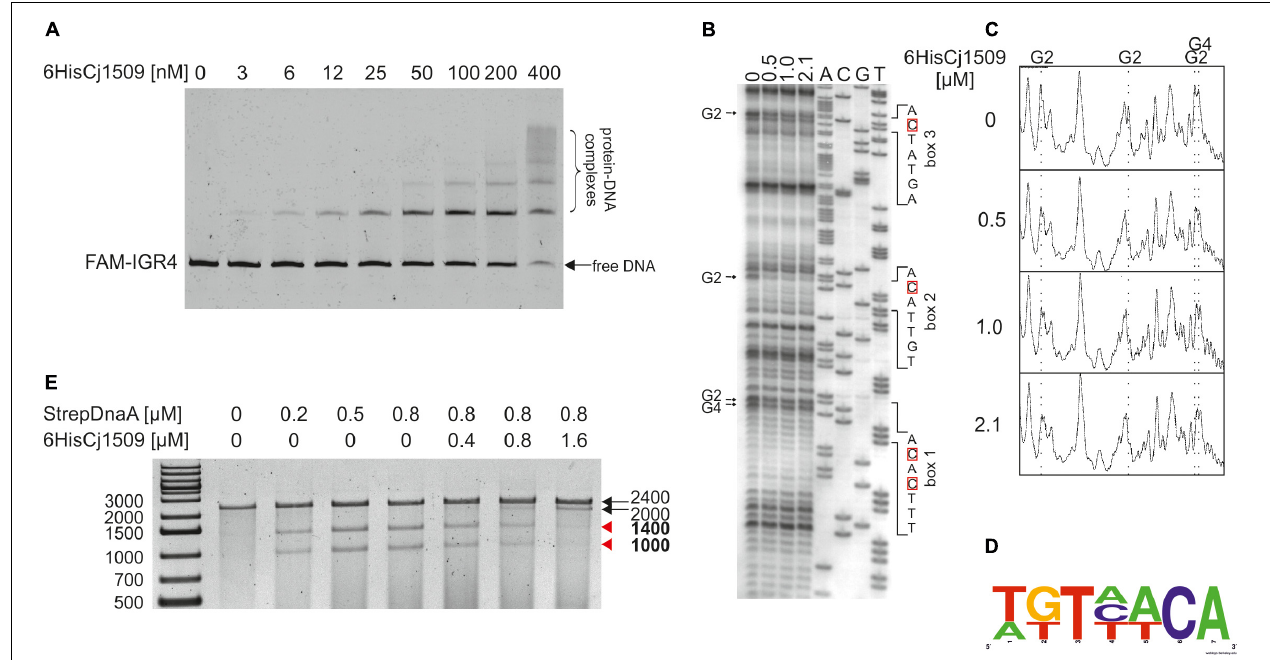
FIGURE 6 | Analysis of 6HisCj1509 protein binding to the IGR4 region and influence of 6His1509 on DUE unwinding. (A) EMSA analysis of nucleoprotein complex formation by 6His1509 and IGR4. FAM-labeled IGR4 (310 bps) was incubated with the indicated amounts of 6HisCj1509 protein. The reaction mixtures were separated by electrophoresis on a 4% polyacrylamide gel. (B) Identification of 6HisCj1509 binding sites by DMS footprinting. pOC_IGR4 was incubated with the indicated concentrations of the 6HisCj1509 protein, methylated with DMS and used as a template for PE reactions with the 32 P-labeled C1 primer complementary to the lower strand. Protected guanosine residues (G) are indicated by arrows presented next to the gel image, while complementary cytosine residues (C) of the 6HisCj1509 binding sequence are denoted by red boxes. (C) Densitometric plot of the DMS analysis; vertical, dotted lines and symbols above the plot correspond to the protected G residues. (D) The consensus sequence bound by C. jejuni 1509 generated with WebLogo based on the identified 6HisCj1509 binding sites. (E) The influence of 6HisCj1509 on DUE unwinding by DnaA. The pOC_IGR4 plasmid was incubated with the indicated amounts of 6HisCj1509 and StrepCjDnaA proteins, treated with P1 nuclease and restriction digested with SspI. DNA fragments were analyzed by separation on a 1% agarose gel and ethidium bromide staining. A map of the pOC_IGR4 plasmid is presented in Figure 2 . Fragments of DnaA-specific unwinding are indicated by red arrowheads next to the